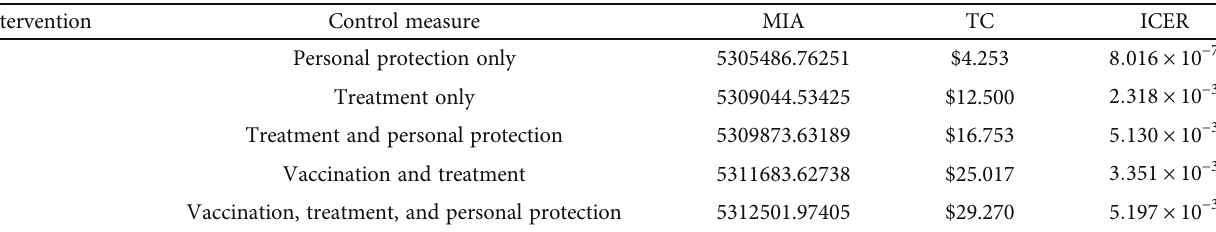
Table 8: Comparing ICER I 3 with I 2 .